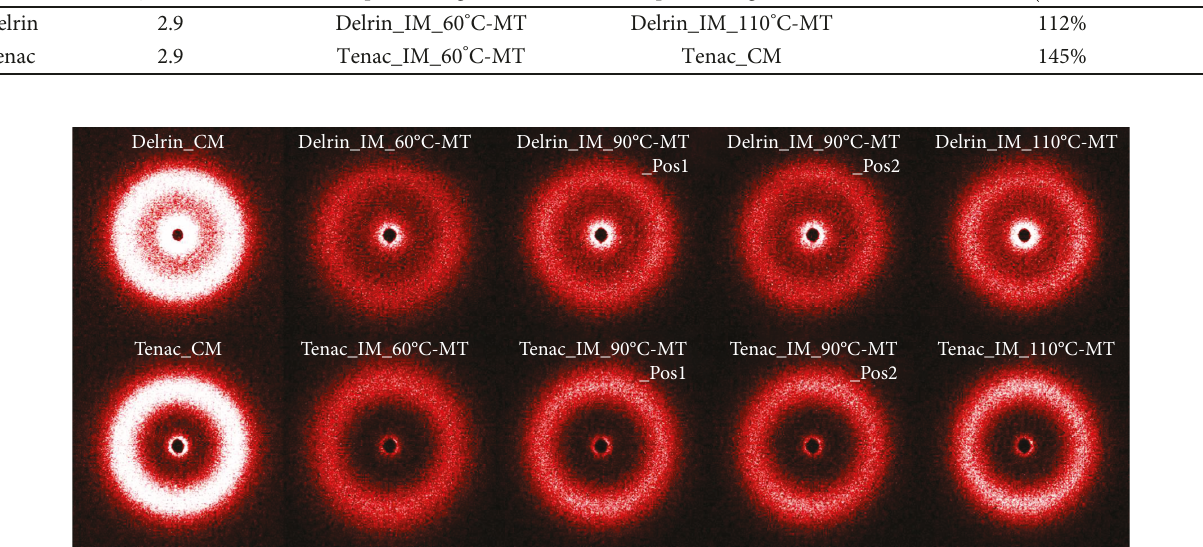
Figure 12: Fatigue fracture tests of CT specimens made of compression- and injection-molded plates. Results for Delrin (a) and Tenac (b). Table 9: Lifetime ratios for Delrin and Tenac calculated for one speci fi c Δ K Resin Δ K init (MPa m 0.5